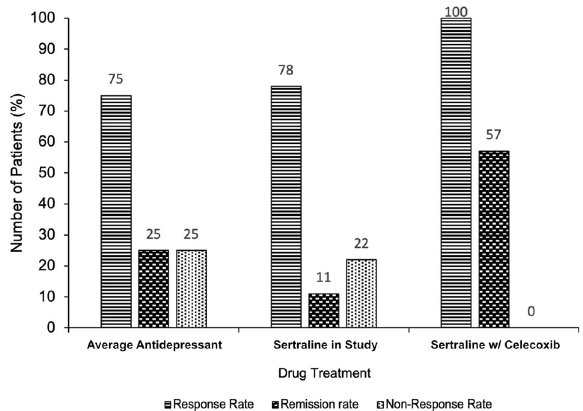
Fig. 2 Approximate mean antidepressant responses in the literature versus responses to sertraline alone and sertraline with celecoxib observed by Majd et al., 2015. A bar chart showing the percentage response rate, remission rate and non-response rate to antidepressant treatment. Responses to three drug treatments are compared: the average fi rst-line selective serotonin reuptake inhibitor (SSRI) (numbers derived from analysis of the wider literature [1, 22, 23], shown on the left, sertraline in drug-naive women (data taken from [58]), shown in the centre, and sertraline in combination with celecoxib in drug-naive women [58], shown on the right. The addition of celecoxib to SSRI treatment dramatically increases the percentage rate of response (100% taking celecoxib vs 75 – 78% taking placebo/nothing) and rate of remission (57% taking celecoxib vs 11 – 25% taking placebo/nothing). This provides evidence as to the ef fi cacy of celecoxib as an adjunctive treatment and suggests it may actively target the treatment-resistant depres- sion